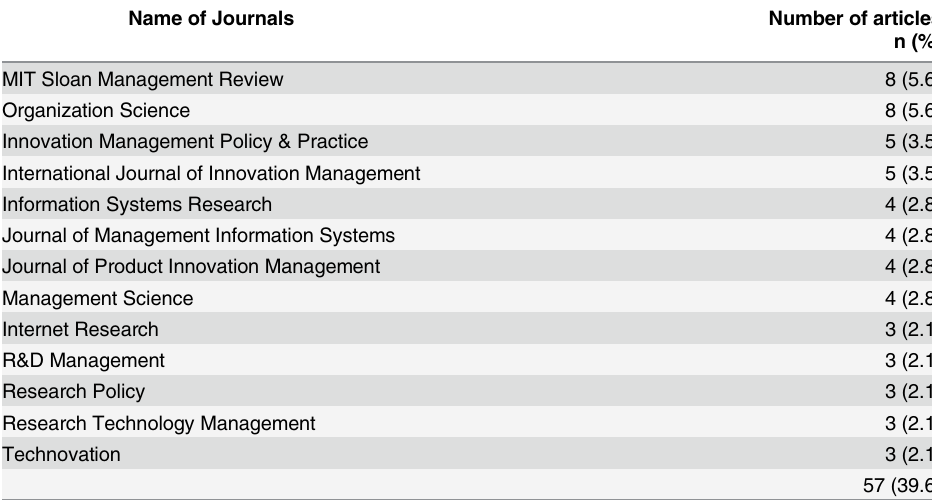
Table 2. Most represented source